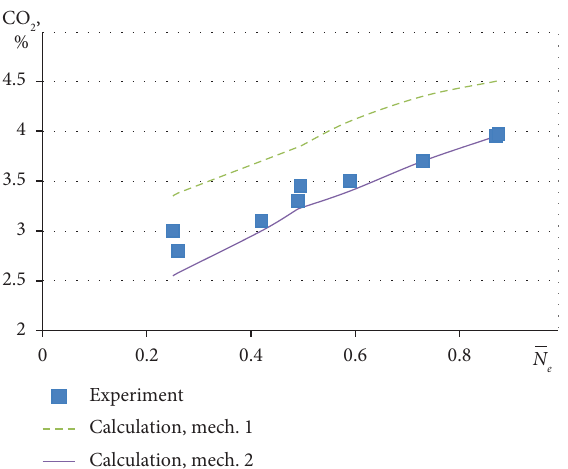
Figure 3: Calculated and measured CO periment; ─ ─ ─ -calculation (mechanism 1); ― -calculation (mechanism 2).